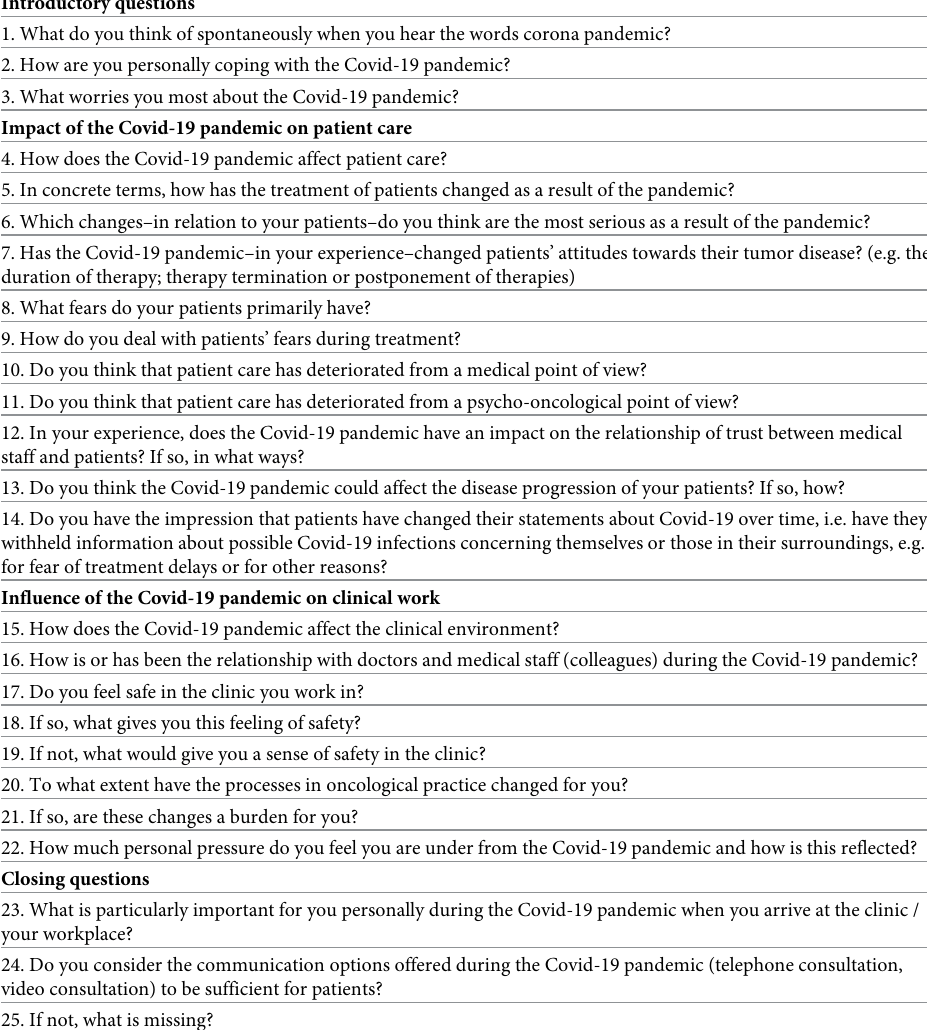
Table 1. Interview guide for nurses and medical